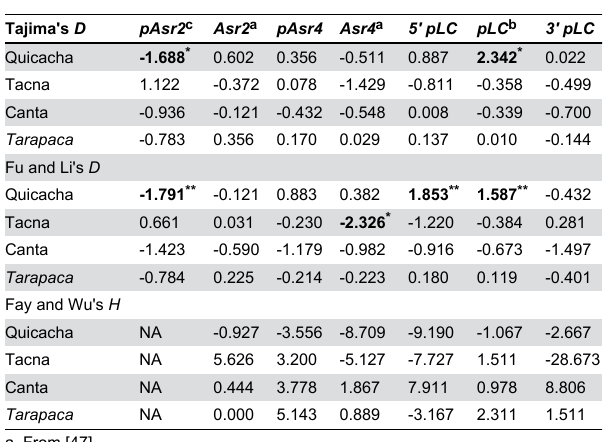
Table 4. Results of the neutrality tests for pAsr2 , pAsr4 , 5’pLC , 3’pLC , and their corresponding